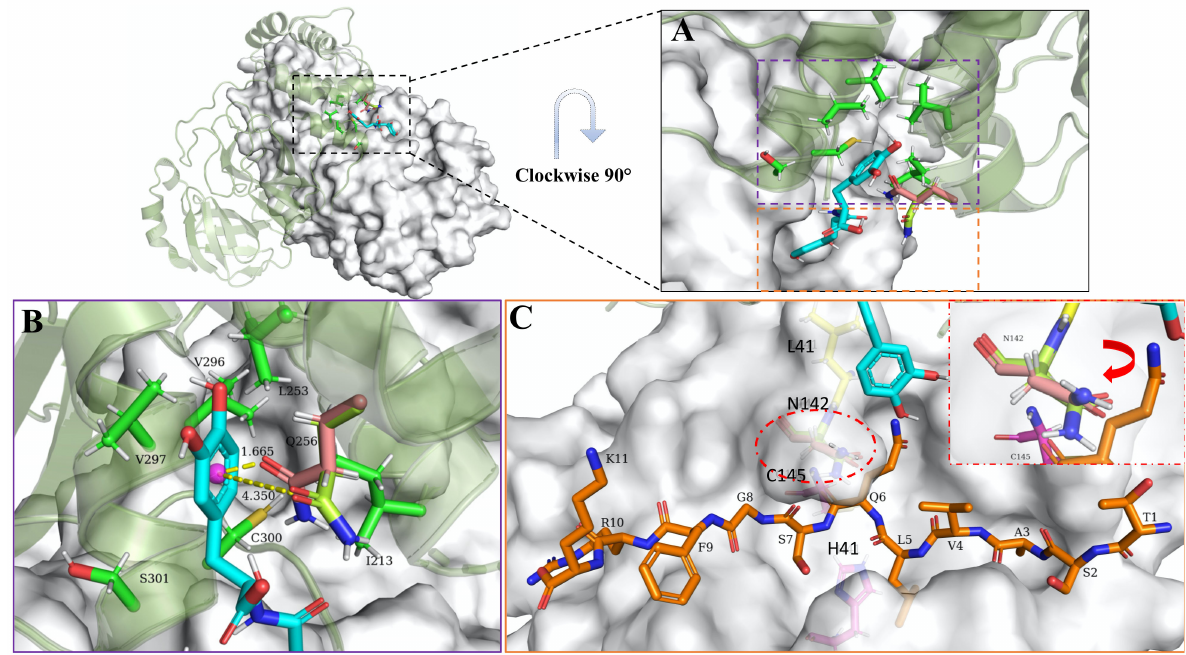
Figure 11. Allosteric site 1 is in direct contact with the opposite protomer. The protomer where the inhibitor binds is represented in ribbon diagram, while the opposing protomer undergoing conformational changes is displayed in surface representation. ( A ) A close-up view of the allosteric site. The bound clovamide molecule is shown in cyan, with the surrounding amino acid residues shown in green. This binding pose can be described in two portions. ( B ) The upper portion mainly involves hydrophobic interactions with a conformational change of Q256 residue. Q256 in raspberry indicates the original position, limon color is the proposed position upon inhibitor binding (PDB: 7AXM). ( C ) the lower portion involves binding-induced conformational changes of both the catalytic active site and the substrate binding pocket. Yellow is the L41 residue that is in proximity of the lower portion of the molecule. The N142 residue swings towards the catalytic domain (raspberry is the original conformation while limon describes the position after conformational change). The catalytic dyad, C145 and H41, is shown in stick in magenta. A short peptide (a known N-terminal substrate) is overlapped to illustrate the substrate binding position, as shown in